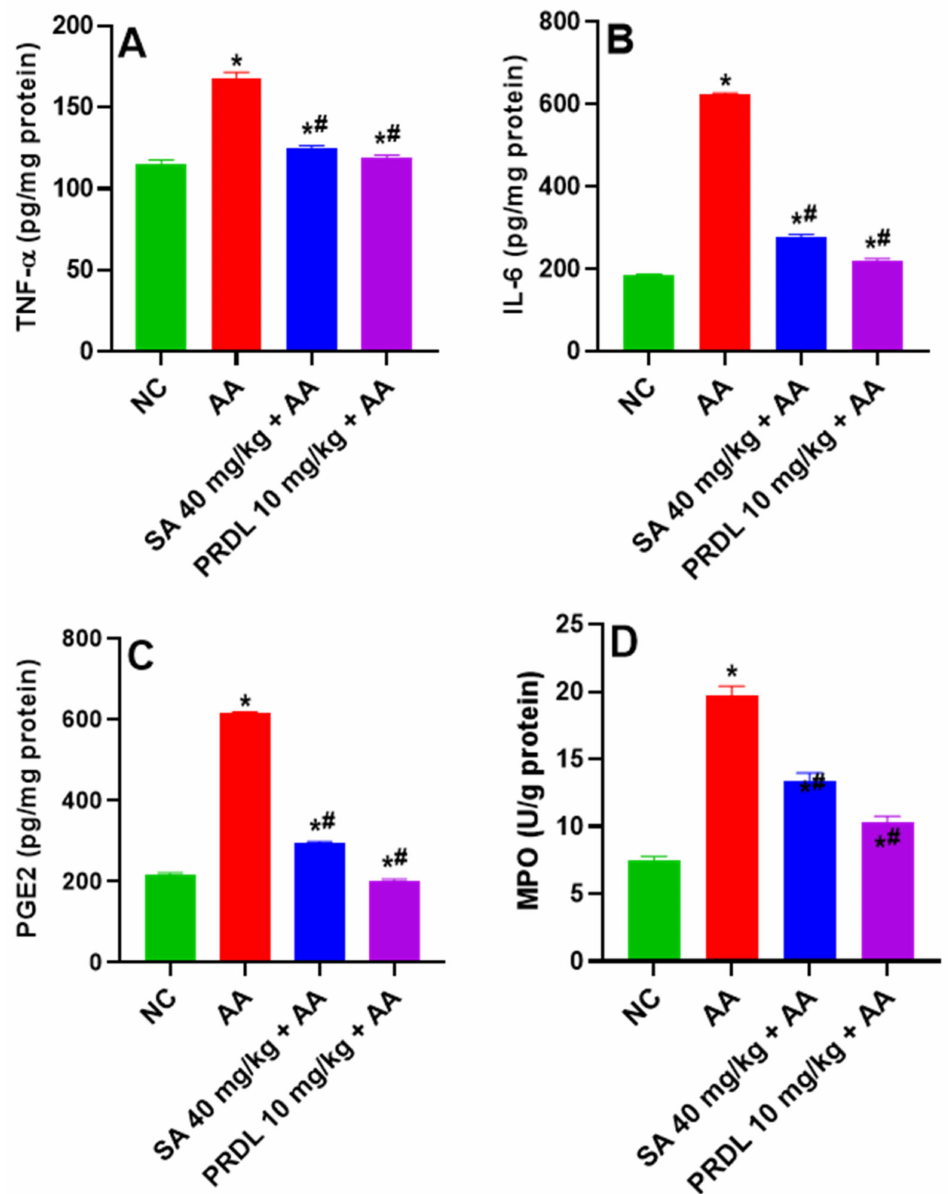
Figure 4. Levels of ( A ) TNF- α , ( B ) IL-6, ( C ) PGE 2 and ( D ) MPO levels in AA-induced ulcerative colitis rats. The results are presented as mean ± SEM ( n = 6) per group. * denotes significant differences compared to the control group ( p < 0.05); # denotes significant differences compared to the AA group ( p <